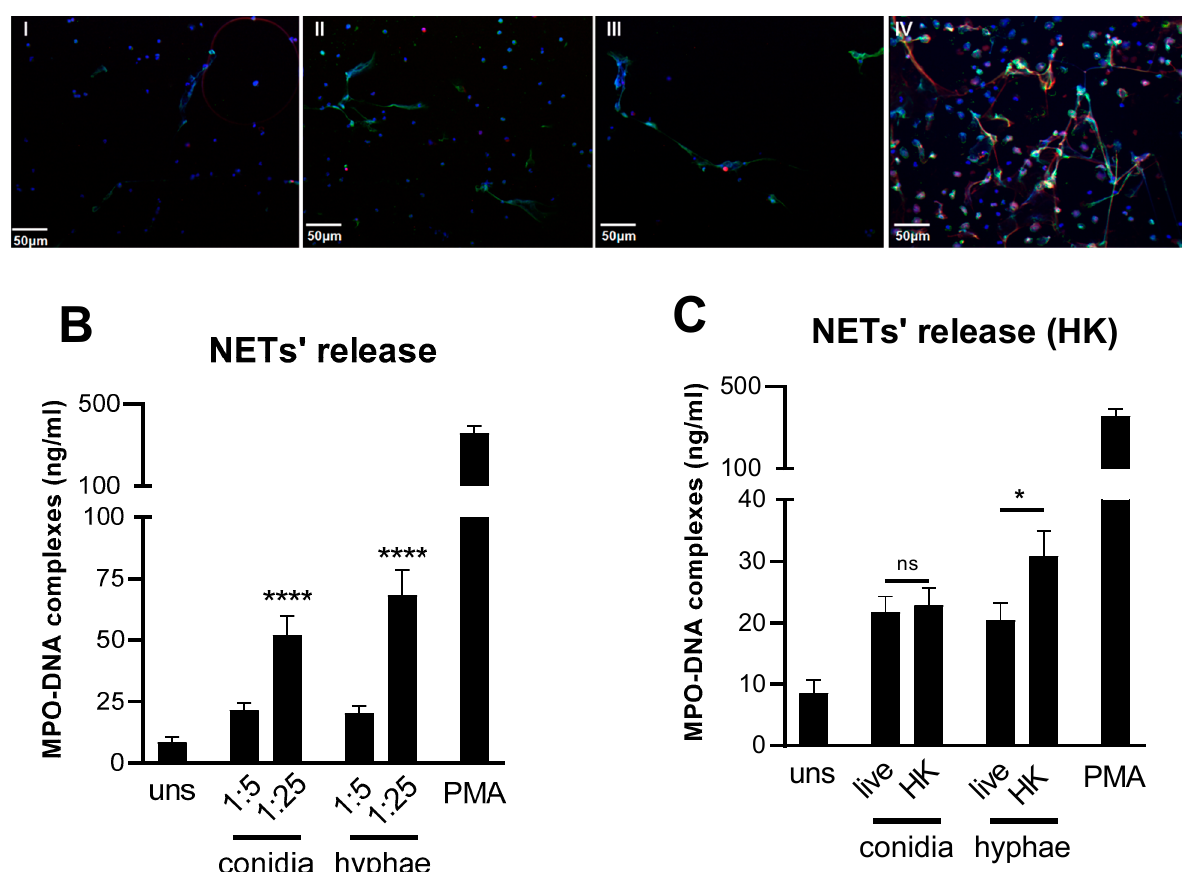
Figure 1. T. rubrum promotes neutrophil extracellular traps (NETs) formation by neutrophils. Human neutrophils were isolated and infected with T. rubrum conidia for 3 h at 37 ◦ C. Phorbol myristate acetate (PMA) of 100 nM was used as a positive control for NET formation. ( A ) (I–IV) Immunostaining of NET components (green, myeloperoxidase; red, histone; DNA Hoechst, blue). Scale bar = 50 µ m. (I) Unstimulated neutrophils incubated for 180 min do not show NETs. Neutrophils stimulated with T. rubrum conidia (II), hyphae (III), or PMA (IV) for 180 min showed NETs. Images were captured using a Nikon Eclipse 80i. Scale bar: 50 µ m. ( B ) NET formation is dose dependent. Neutrophils were incubated for 3 h at 37 ◦ C with different ratios of T. rubrum morphotypes (conidia or hyphae) (multiplicity of infection (MOI) 1:5 or 1:25), and myeloperoxidase (MPO)-DNA complexes were measured in the culture supernatants. ( C ) Fungal viability is not essential for NET induction. Neutrophils were incubated for 3 h at 37 ◦ C with live or heat-killed (HK). T. rubrum morphotypes and MPO-DNA complexes were measured in the culture supernatants. NET quantification was performed using the MPO-DNA PicoGreen assay. Data are presented as the mean ± SEM of three independent experiments. One-way ANOVA and Bonferroni’s post-test: ns, not significant; * p < 0.05; **** p < 0.0001.